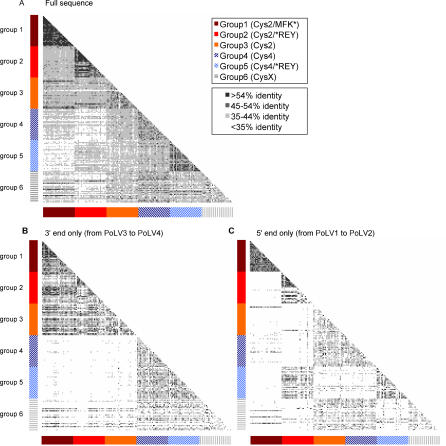
Global Comparisons of Sequences Falling in Six Sequence GroupsUsing ClustalW, pair-wise sequence identity comparisons were made between 30 randomly selected, distinct sequences from each sequence group. Pair-wise comparisons are expressed in an identity matrix, in which the percent identity between pairs of sequence is represented in different shades of gray.(A) Full-length sequence comparisons.(B) Sequence comparisons of the region from the 5′ end of PoLV3 to the 3′ end of PoLV4.(C) Sequence comparisons of the region from the 5′ end of PoLV1 to the 3′ end of PoLV2.